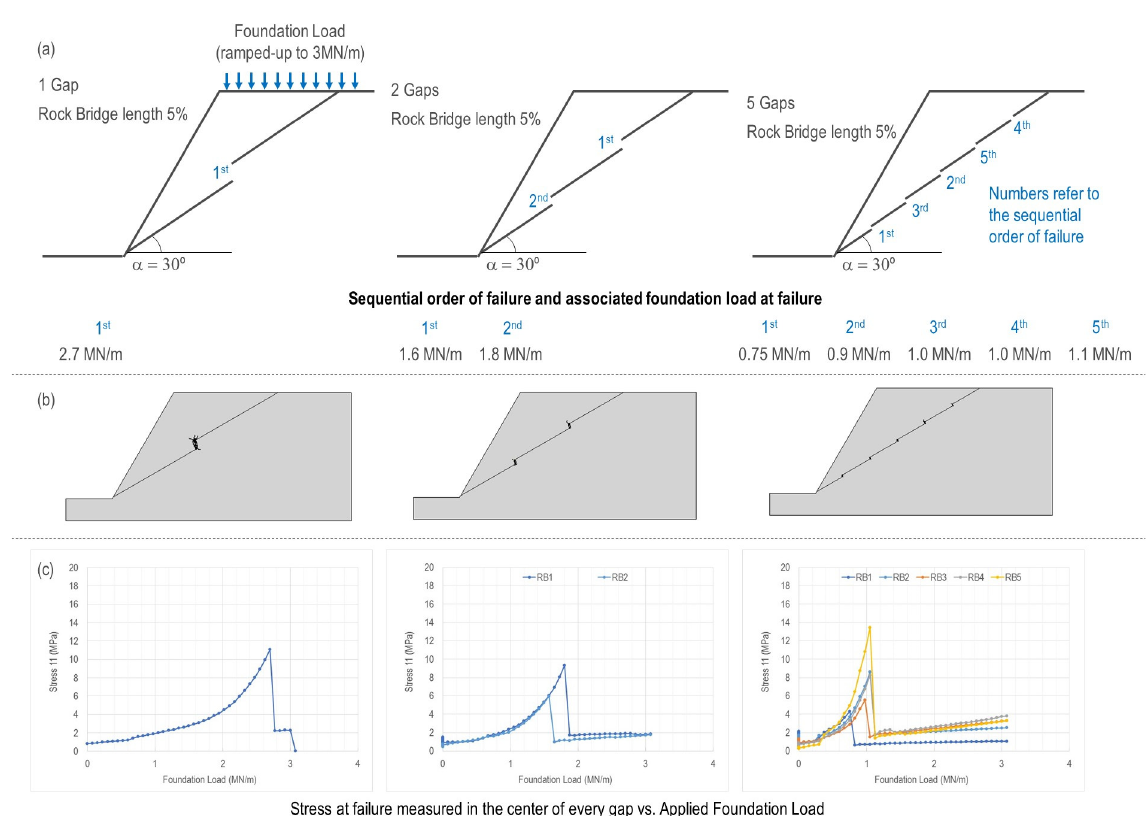
Figure 6. Results for the numerical simulations with 1, 2, and 5 rock bridges, respectively (modified from [18]). ( a ) Geometries and loading conditions; ( b ) fracturing results; and ( c ) principal stress sigma 11 measured at the midpoint of every rock bridge.